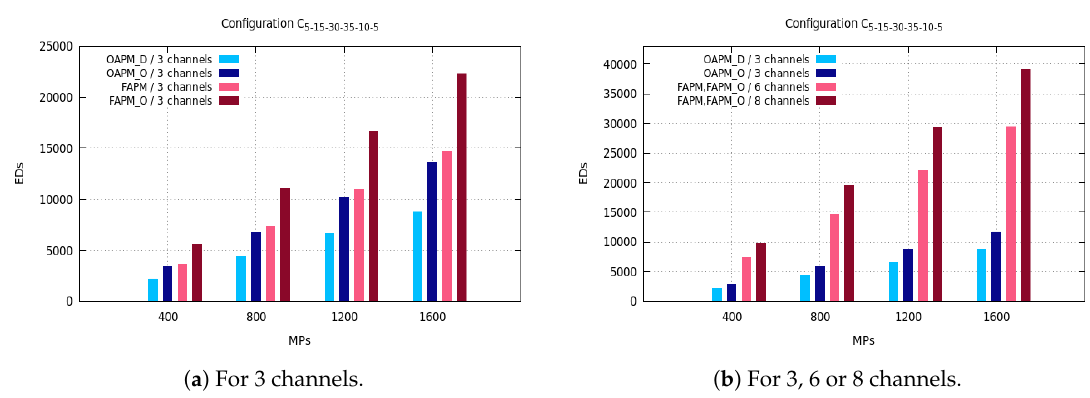
Figure 7. Number of EDs supported by OAPM_D, OAPM_O, FAPM and FAPM_O in C 5,15,30,35,10,5